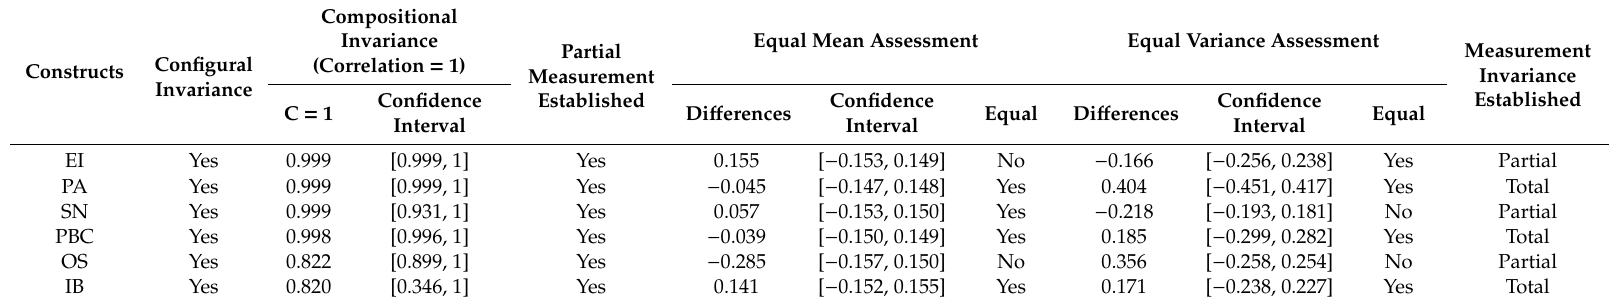
Table 8. Results of invariance measurement testing using permutation.